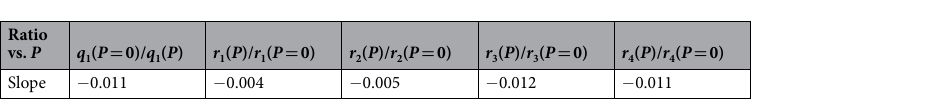
Table 1. Ratio parameters from experimental S ( q ) and calculated g ( r ) of liquid GaIn alloy changing with pressure P during compression below 4 GPa. q 1 : first-peak position of experimental S ( q ); r 1 , r 2 , r 3 and r 4 : the first four peak positions of calculated g ( r ),